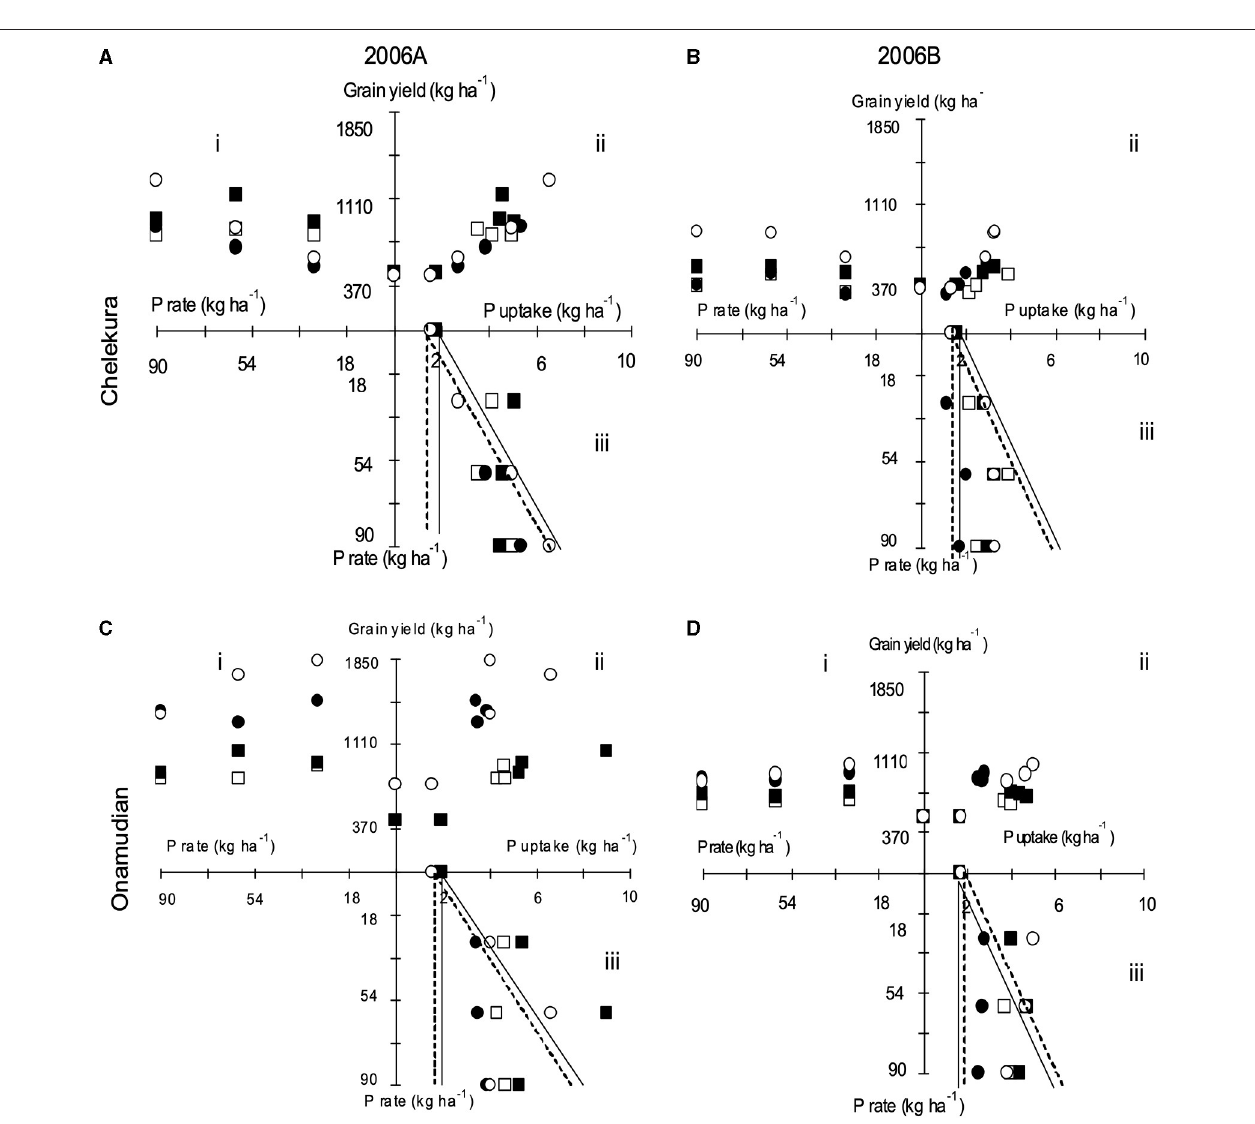
FIGURE 3 | Three-quadrant diagrams showing relationships between P application, P uptake, and grain yield of finger millet. (i) Yield against fertilizer P rate (fertilizer use efficiency), (ii) yield against P uptake (physiological P use efficiency), (iii) P uptake against fertilizer application rate (fertilizer recovery) in degraded fields located on the upper and middle landscape positions in Chelekura (A,B) and Onamudian (C,D) village during seasons 2006A (A,C) and 2006B (B,D) . Open square, P alone, upper landscape position; full square, N + P, upper landscape position; full circle, nitrogen alone, middle landscape position; open circle, N + P, middle landscape position. Areas under bold line and dotted lines respectively represent ANR under 25% in the upper and middle landscape positions,